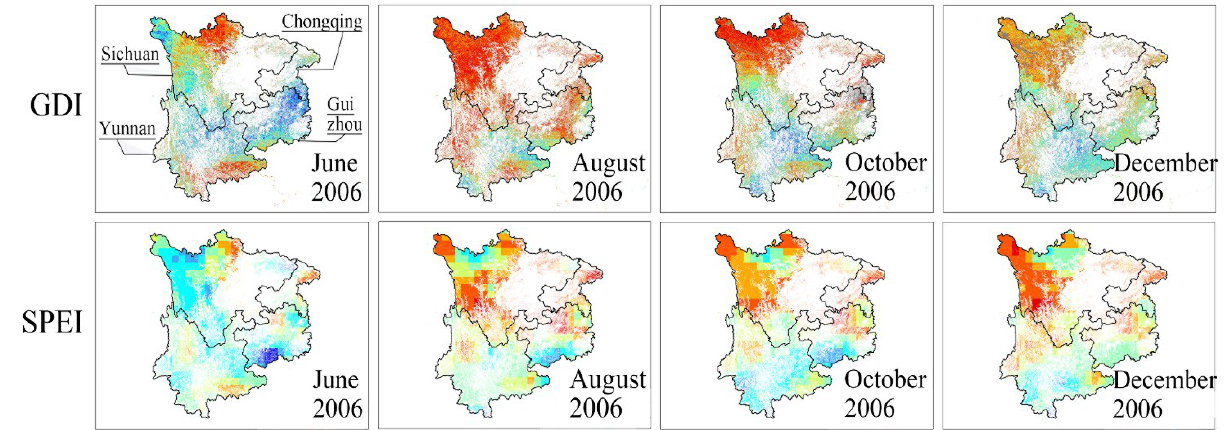
Figure 14. The performance of the global products of GDI-6CRU and SPEI-6mon in grassland regions, regarding the drought event in summer of 2006, Southwest China. The classification scheme of GDI-6CRU and SPEI SPEI-6mon are same with the scheme adopted in Figures